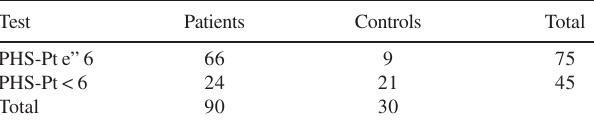
Table 3 - Values for cases and non-case of the Portuguese Version of the Personal Health Scale according to the cut- off score of 6.